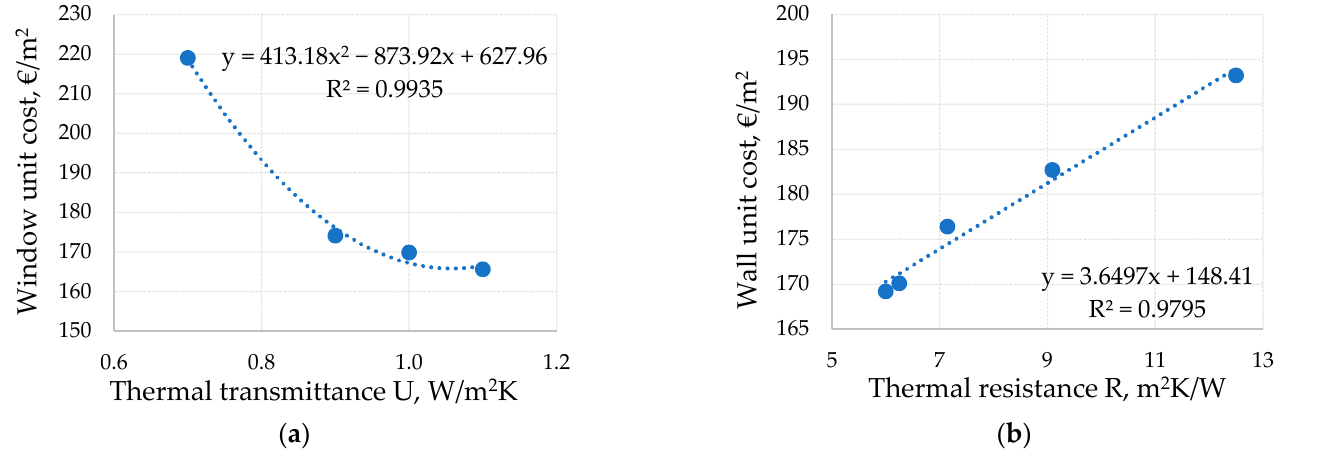
Figure 3. According to Estonian real estate market the unit investment cost of ( a ) window and ( b ) wall.